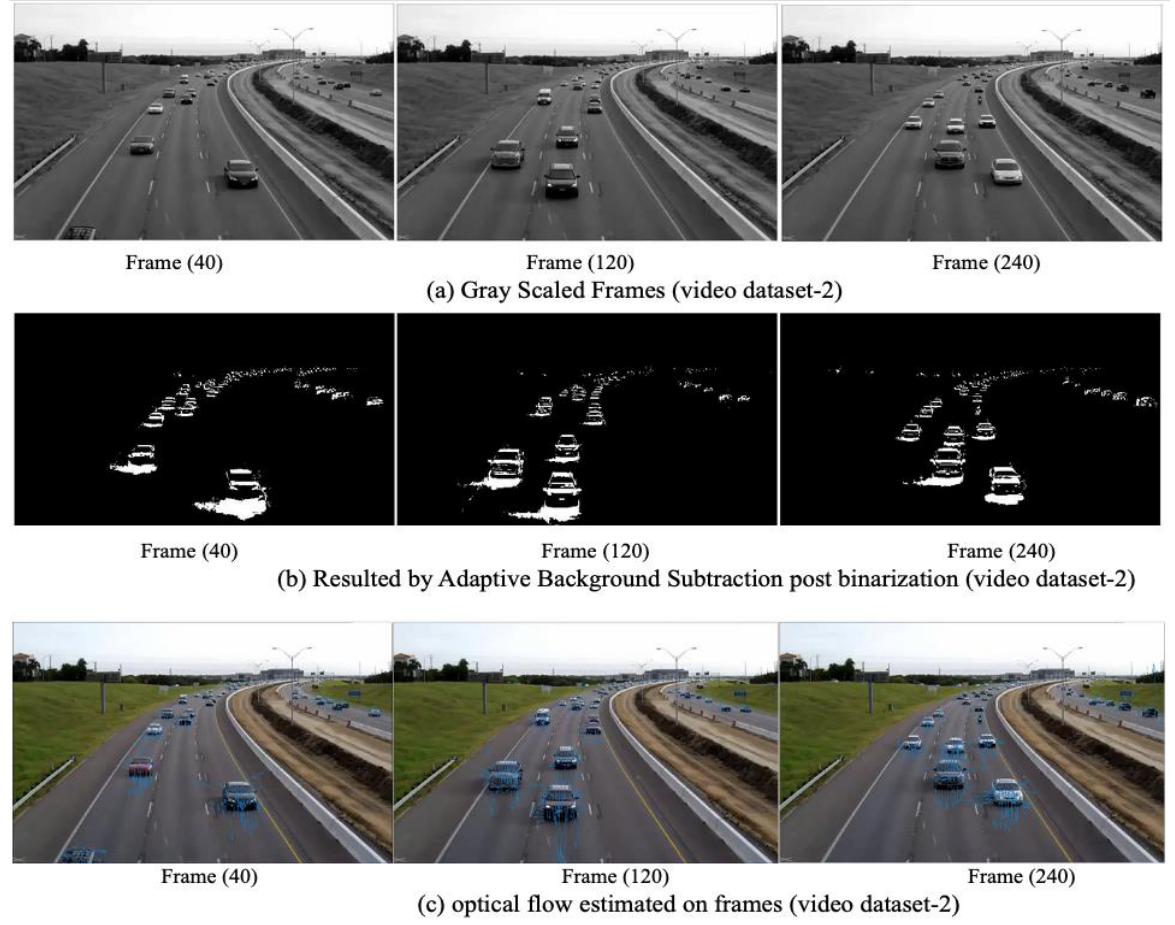
Figure 6. Simulation from video dataset 2 by the proposed framework (( a ) extracted frames in gray- scale, ( b ) foreground by adaptive background subtraction post-binarization and ( c ) optical flow).